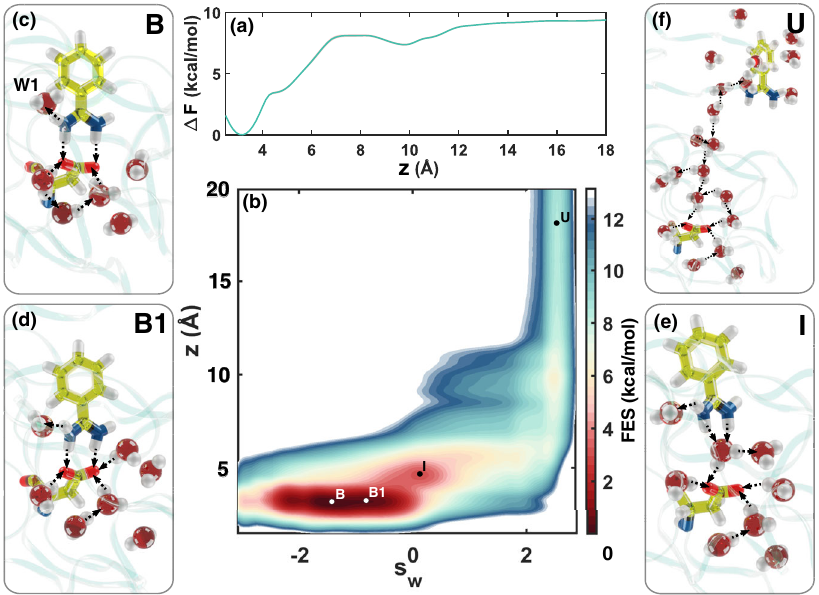
s – f Representative con fi gurations of the relevant states are shown with a w CVs. c focus on the solvation pattern around the ligand and the binding pose.